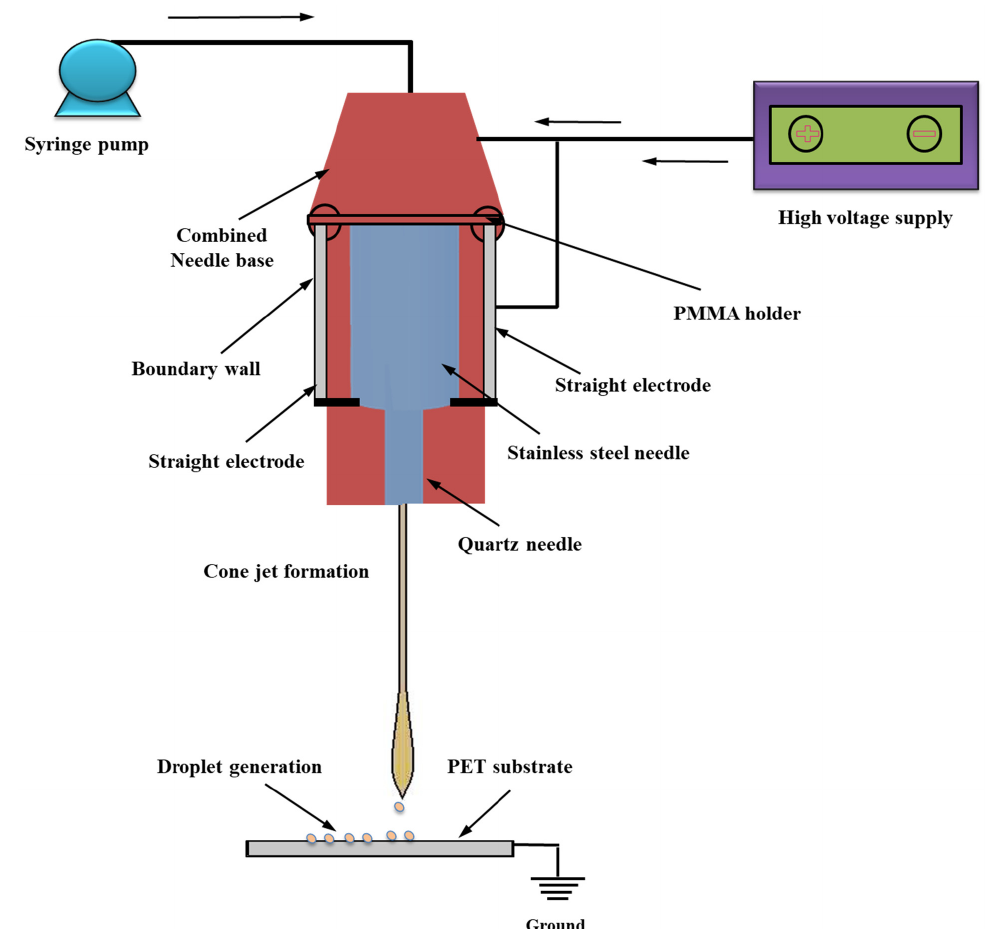
Figure 3. Schematic diagram of DoD e-jet printing method.